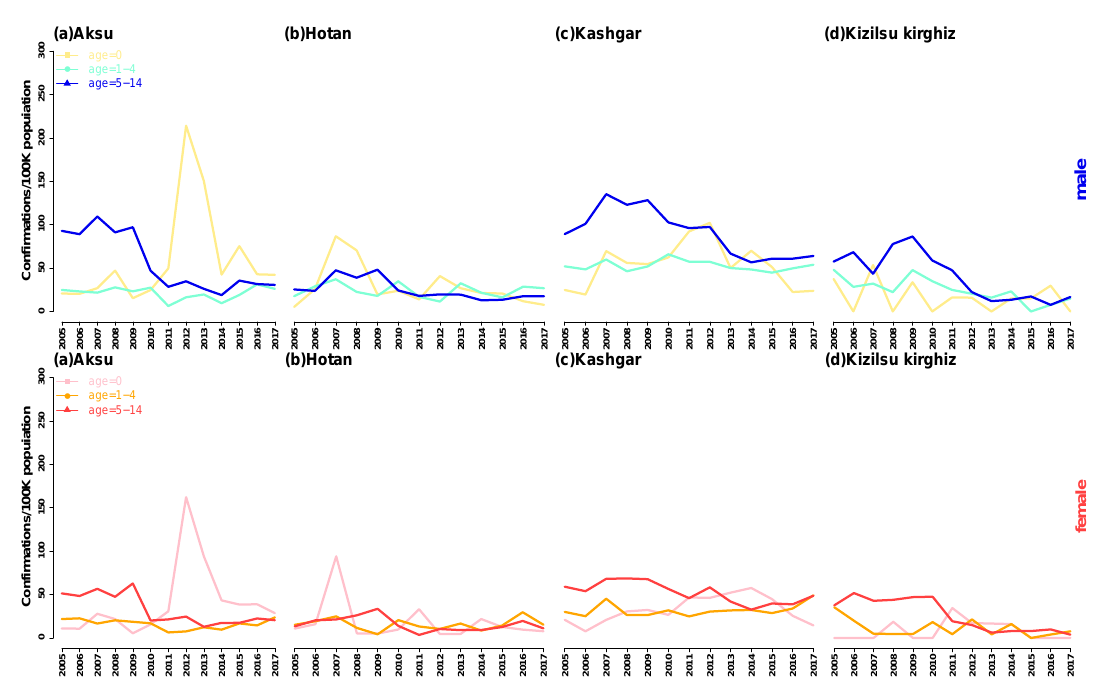
Figure 7. Annual incidence of HB among male and female children in four regions of Xinjiang, China, from 2005 to 2017. In male children, the yellow line indicated 0-year-old infant, the green line indicated 1–4-year-old infant, and the blue line indicated 5–14-year-old school age. In female children, the purple line indicated 0-year-old infant, the orange line indicated 1–4-year-old infant, and the red line indicated 5–14-year-old school